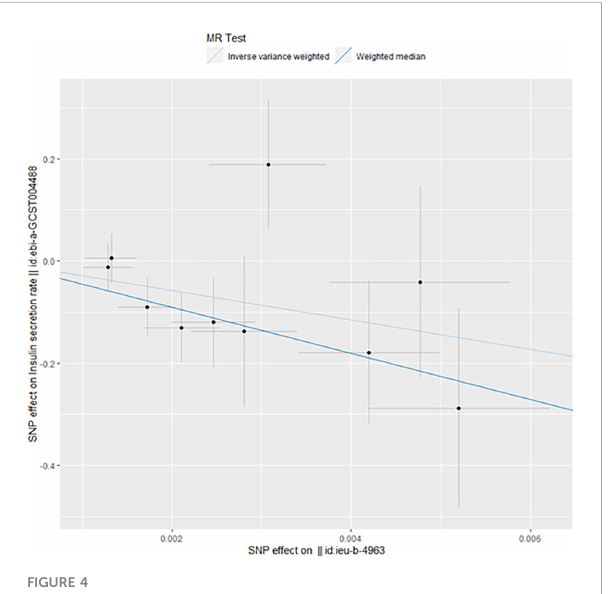
FIGURE 4 Mendelian randomization results of the association of ovarian cancer on the insulin secretion rate (Reverse).